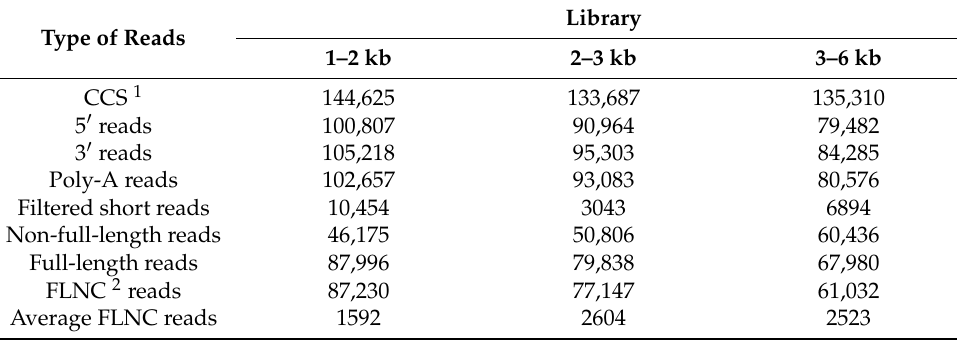
Table 2. Classification of circular consensus sequences in full-length sequencing.